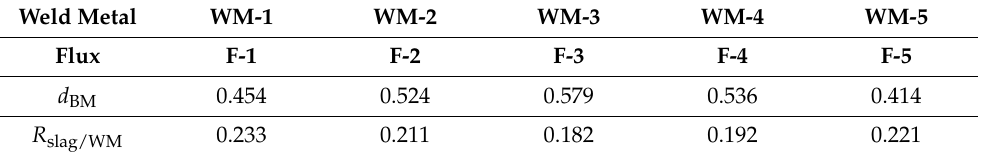
Table A1. The d BM value and estimated mass ratio of slag to WM (wt.%). Weld Metal